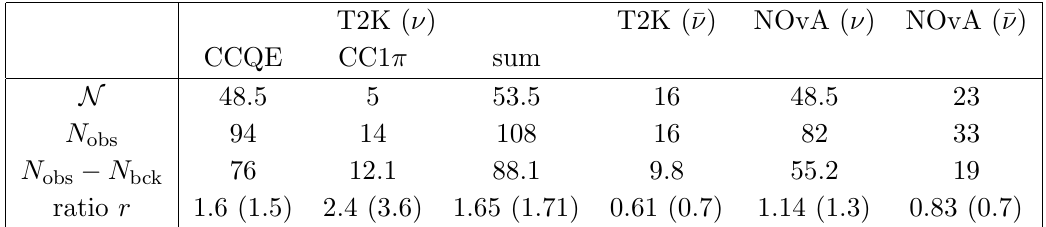
Table 1 . Normalization coe(cid:14)cients N (cid:23) and N (cid:22) (cid:23) in eqs. (2.4) and (2.5) for approximations used to qualitatively describe the appearance event samples for T2K and NOvA. We also give the observed number of events, as well as the corresponding background subtracted event numbers, as reported in refs. [8, 10]. The ratio in the last line is de(cid:12)ned as r = ( N obs (cid:0) N bck ) = N and numbers in brackets are the corresponding values for the data set used for NuFIT